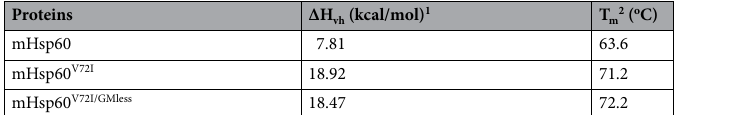
Table 1. Thermodynamic parameters from thermal unfolding of mHsp60 proteins via circular dichoism (CD). 1 van’t Hoff enthalpy, derived from fitting data to Eq. (1); 2 the temperature of the transition midpoint, derived from fitting data to Eq.